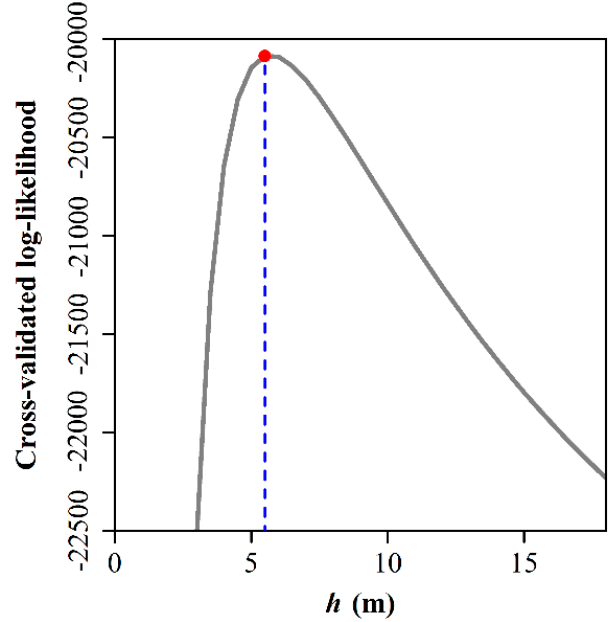
Figure 2. Cross-validated log-likelihood for the six dominant tree species. The grey curve represents the cross-validated log-likelihood values corresponding to different candidate bandwidths ( h ). The cross-validated log-likelihood associated with h = 5.5 m is maximal (see the red point at which the grey curve and the blue vertical dashed line intersect).